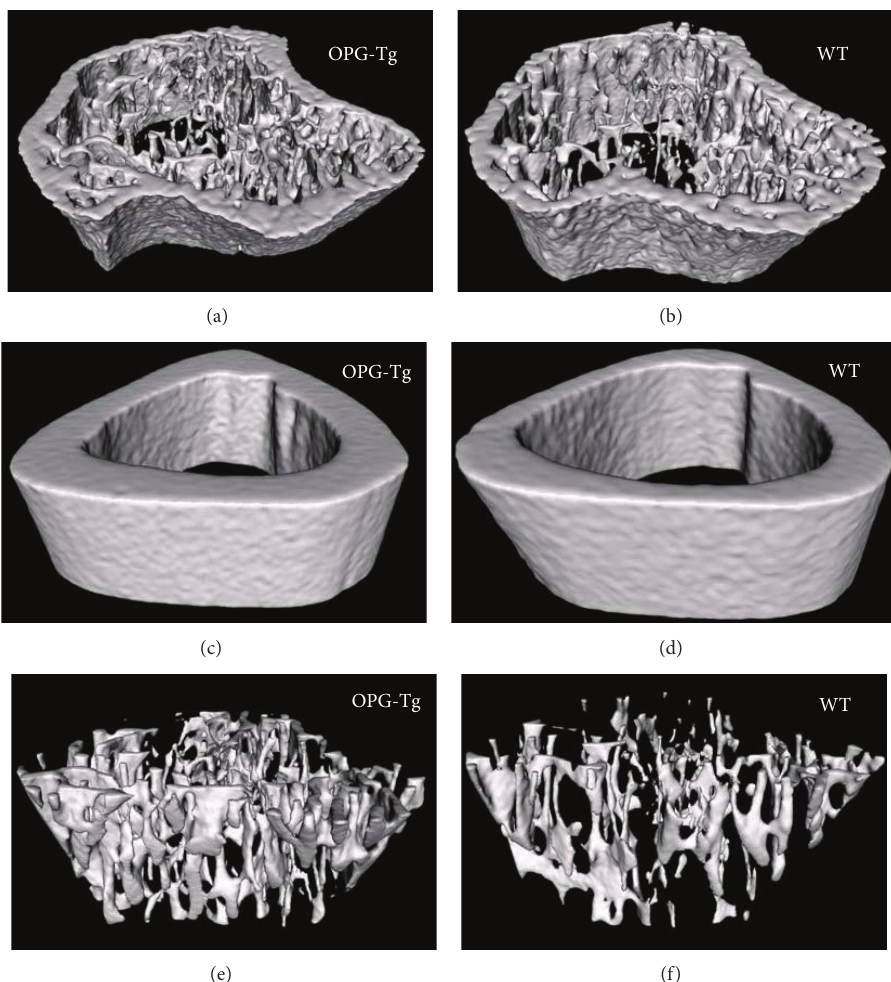
Figure 4: Three-dimensional micro-CT images of the right tibia from two types of mice. (a) Image of the right tibia of OPG-Tg mice; (b) image of the right tibia of WT mice; (c) image of the cortex of OPG-Tg mice; (d) image of the cortex of WT mice; (e) image of the trabecular of OPG-Tg mice; (f) image of the trabecular of WT mice.